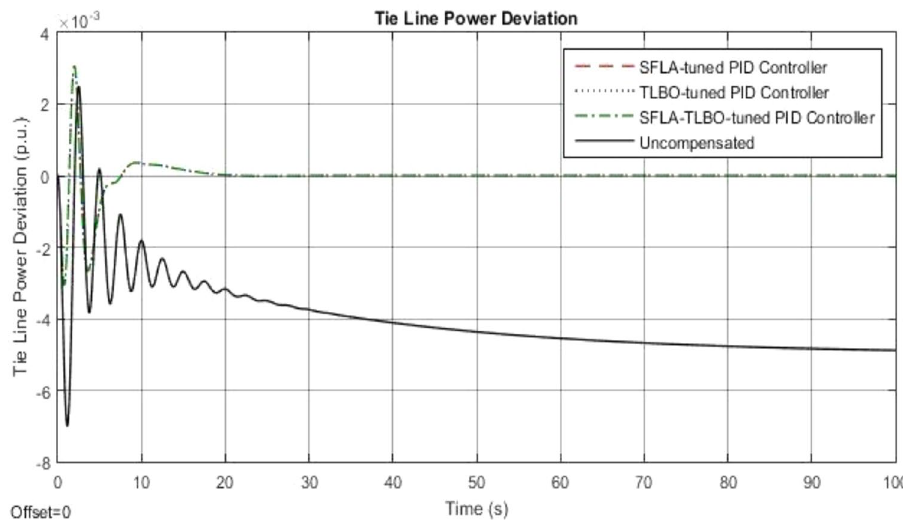
Fig. 9 Tie-line power deviation for two-area system